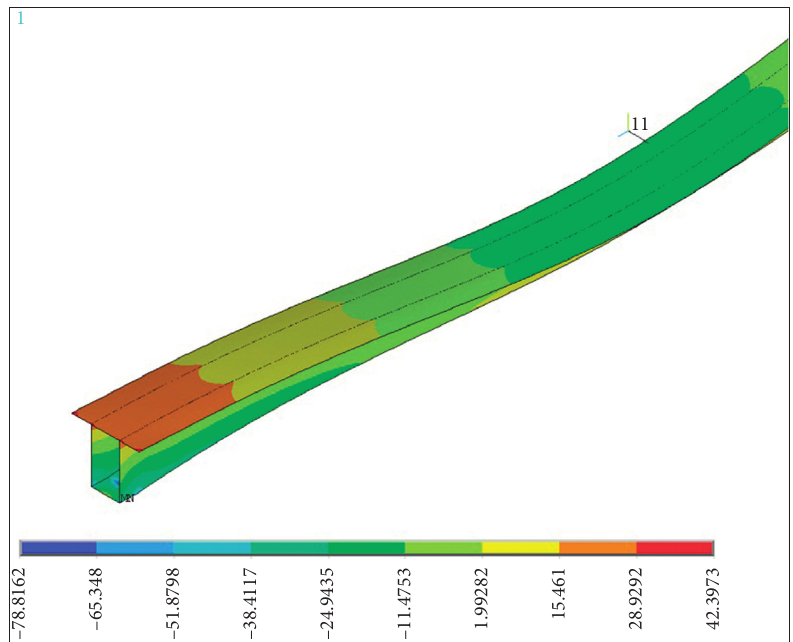
Figure 2: Stress distribution along the Z direction.